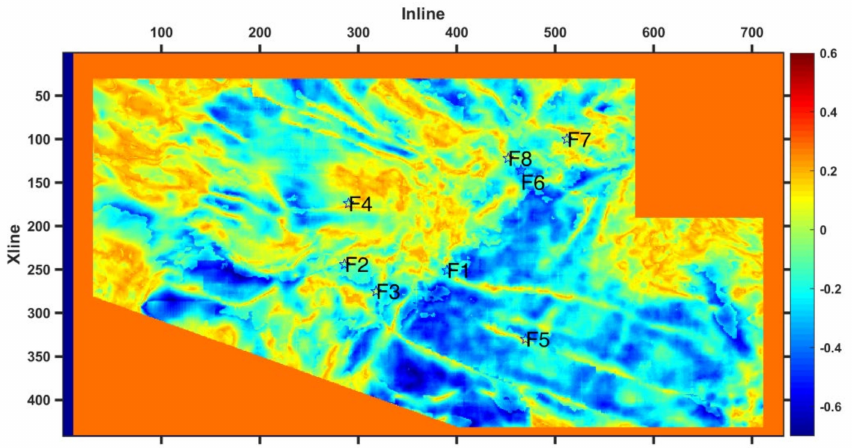
Figure 15. Principal component analysis results of the seismic attributes. Seismic data, such as instantaneous amplitude, waveform difference, instantaneous frequency, frequency band width, and attenuation coefficient, of coal seam 3 were taken as input data and the SVM model was used for fault prediction. The fault prediction results label is 1, which represents the fault. A white label with a value of 0 indicates